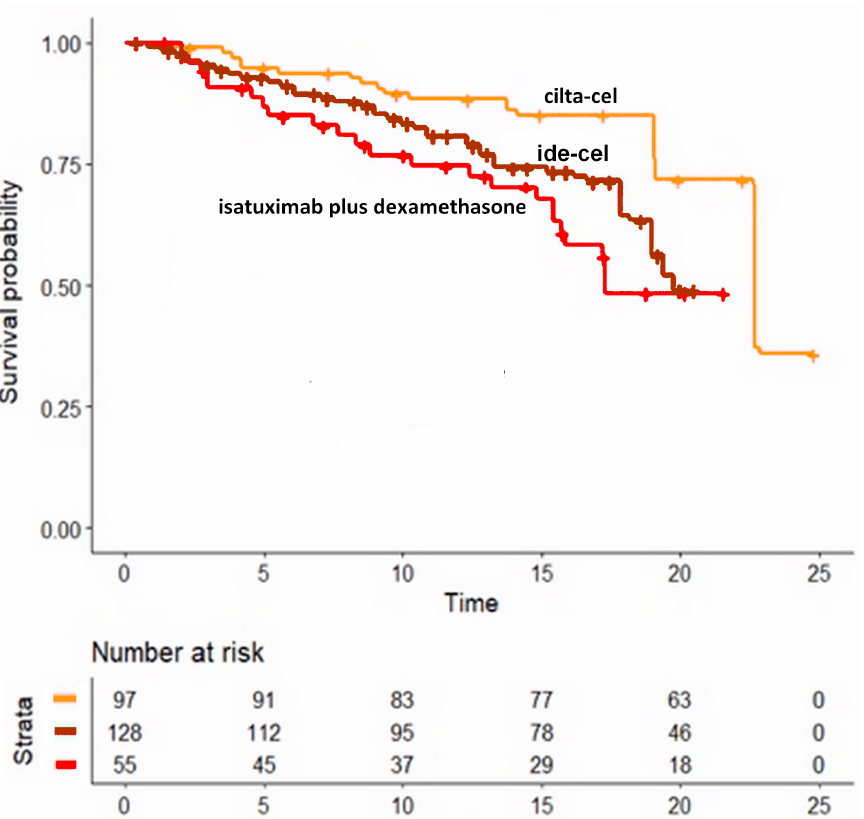
Figure 3. Kaplan-Meier curves from reconstructed patient-level data. These three survival curves were obtained by reconstruction of individual patient data from three trials: ciltacabtagene au- toleucel (CARTITUDE-1), idecabtagene vicleucel (KarMMa), and isatuximab plus desamethasone (NCT01084252). The cohort given ciltacabtagene autoleucel consisted of 97 patients, (CARTITUDE-1 N = 97); the cohort given idecabtagene vicleucel consisted of 128 patients, (KarMMa N = 128); and the cohort given isatuximab plus desamethasone consisted of 55 patients, (NCT01084252 N = 55). Symbols: isatuximab plus dexamethasone in red, ciltacabtagene autoleucel in orange, idecabtagene vicleucel in brown; time is expressed in months. The curve for isatuximab plus dexamethasone is reported to make this figure more easily comparable to Figure